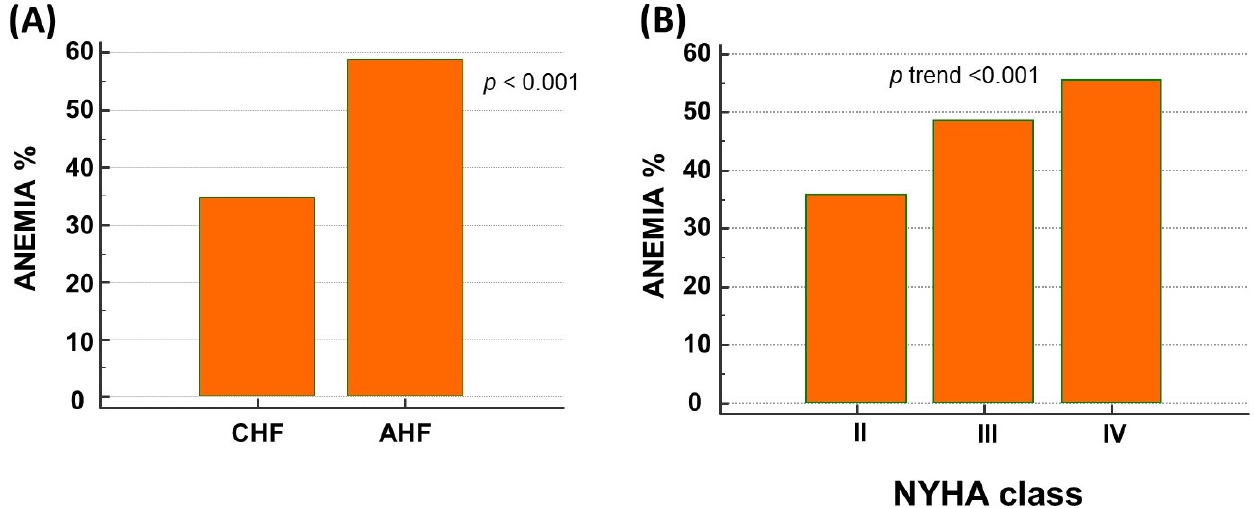
Figure 1. ( A ) Prevalence of anaemia in patients with acute (AHF) and chronic heart failure (CHF). ( B ) Relationship between anaemia and NYHA functional class.